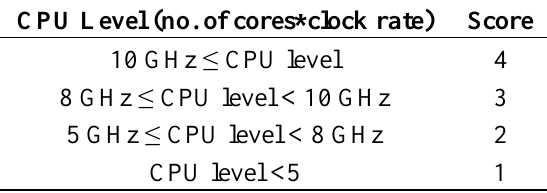
Table 2. The score table of CPU levels.